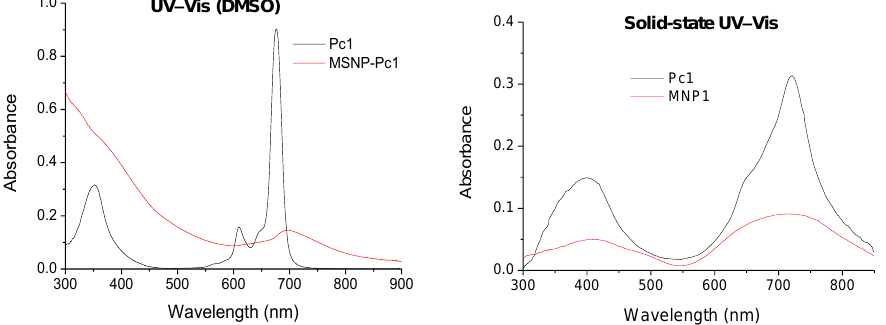
Figure 1. UV–Vis spectra in DMSO (left) and in solid-state (right) spectra of Pc1 (black line) and MSNP-Pc1 (red line).